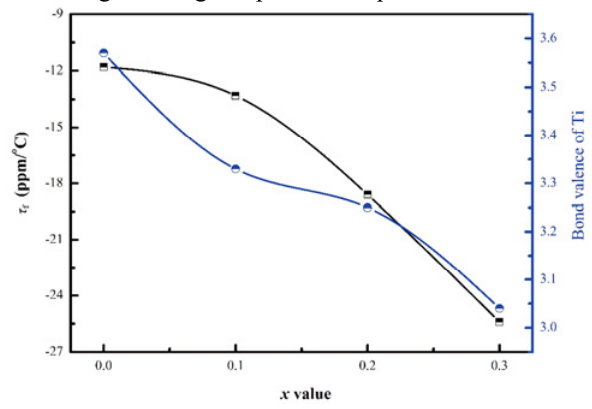
Fig. 10 Relationship between τ f value of LZTNN x ( x = 0–0.3) ceramics and bond valence of